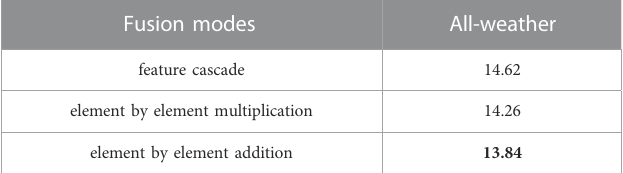
TABLE 3 MRs of different modal